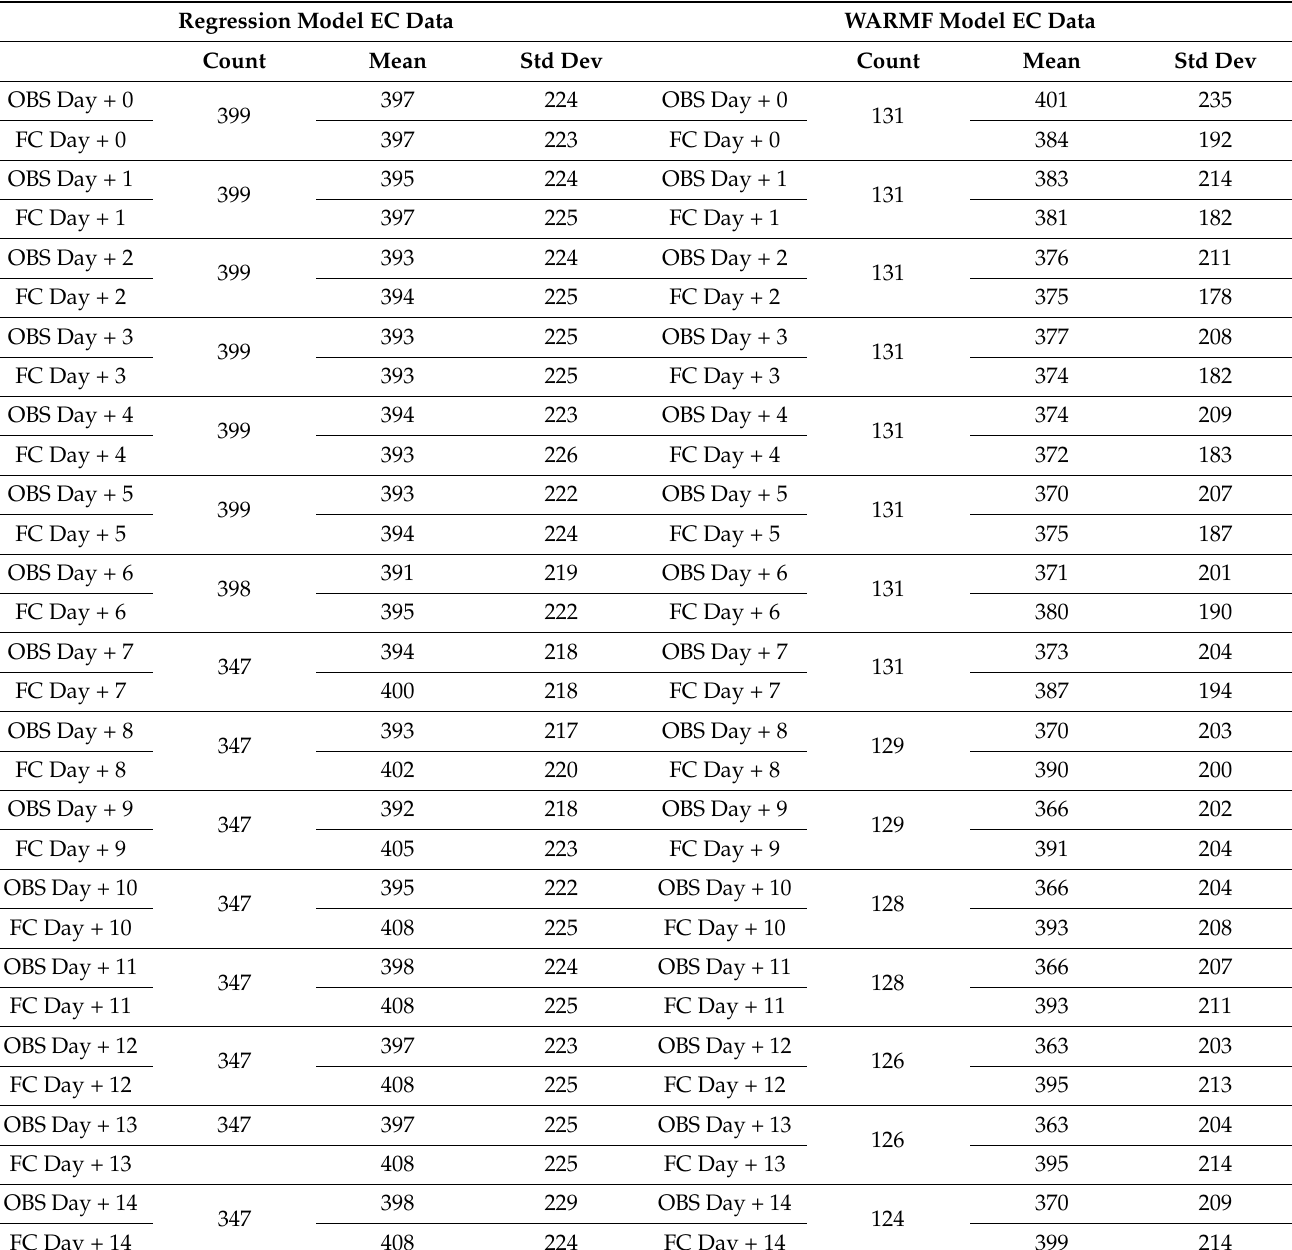
Table 2. Statistics of observed (OBS) and forecasted (FC) EC ( µ S/cm) for the Regression and WARMF models made between 22 February 2018 and 22 May 2020 by lead